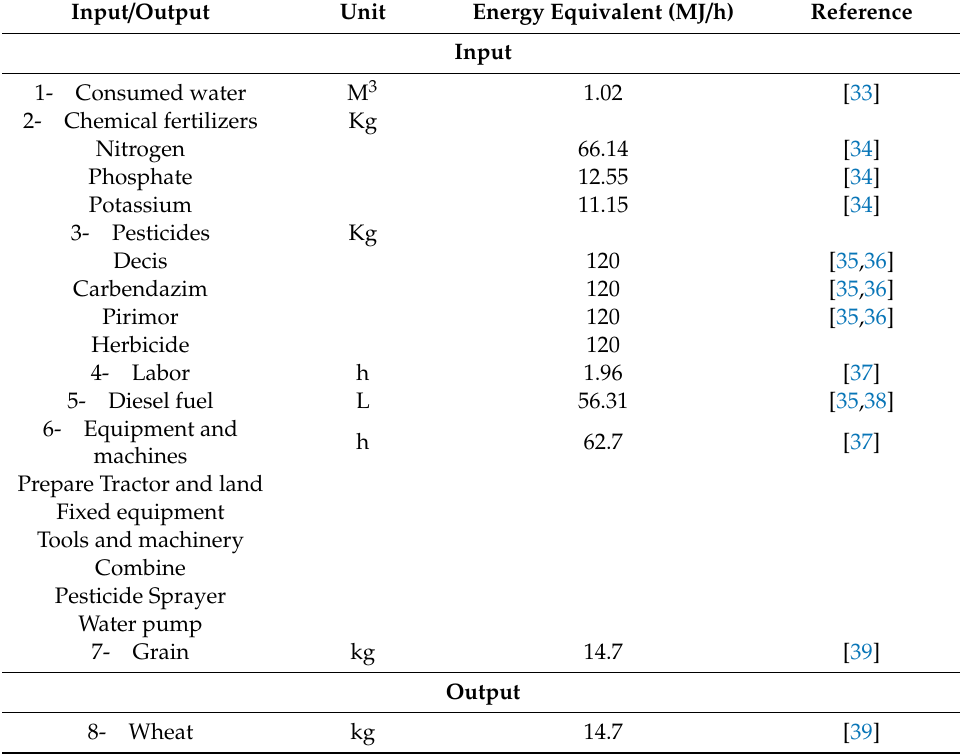
Table 3. Energy conversion